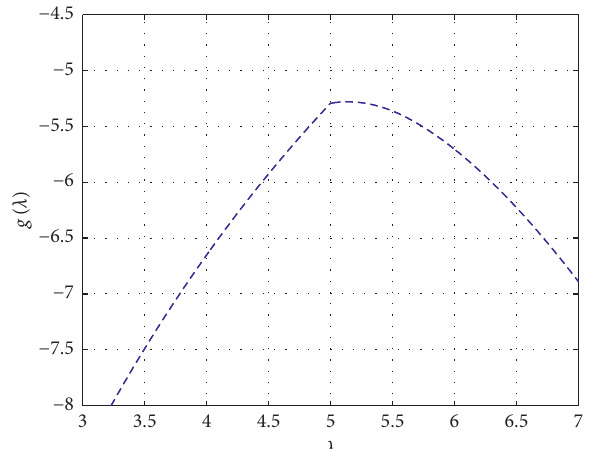
Figure 4: Convergence of log of y when the primal problem (39) is solved using the gradient method followed by the primal decomposition. This shows that a high accuracy for the convergence of y k can be achieved within 1000 iterations even for high dimensional y .